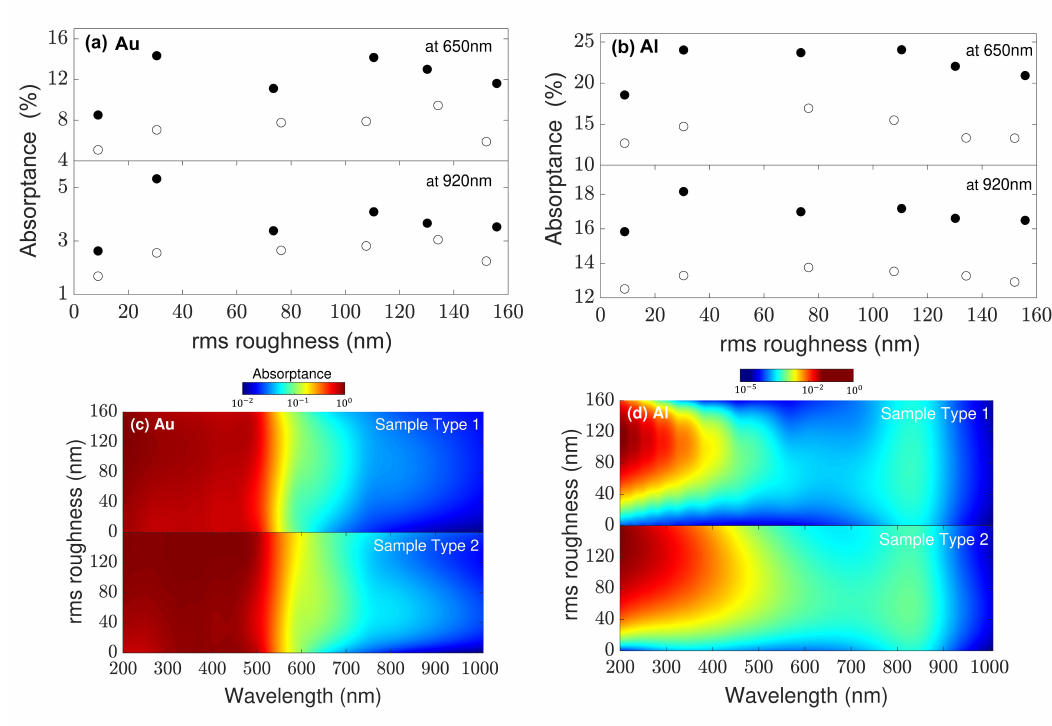
Figure 6. Same as in Figure 5, replacing the material function of silver with the corresponding functions for ( a , c ) gold and ( b , d )